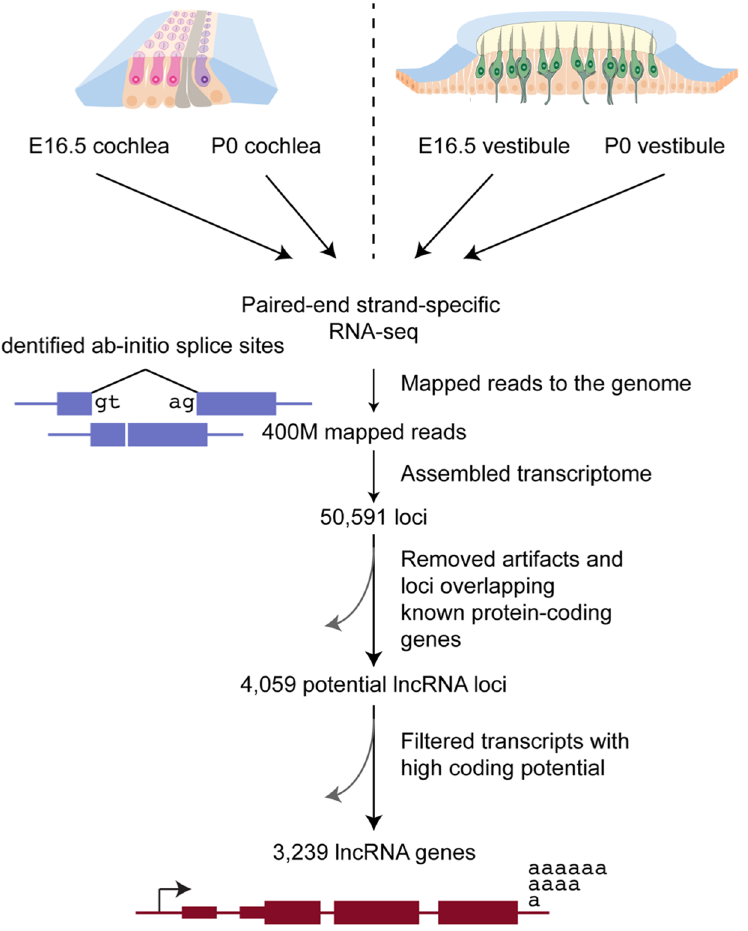
Figure 1. The long noncoding transcriptome of the inner ear sensory epithelium. The experimental and bioinformatic pipeline used for identifying lncRNAs in the inner ear. Extended details regarding bioinformatic programs used are found in the Methods section. Cochlea image modified from ref.